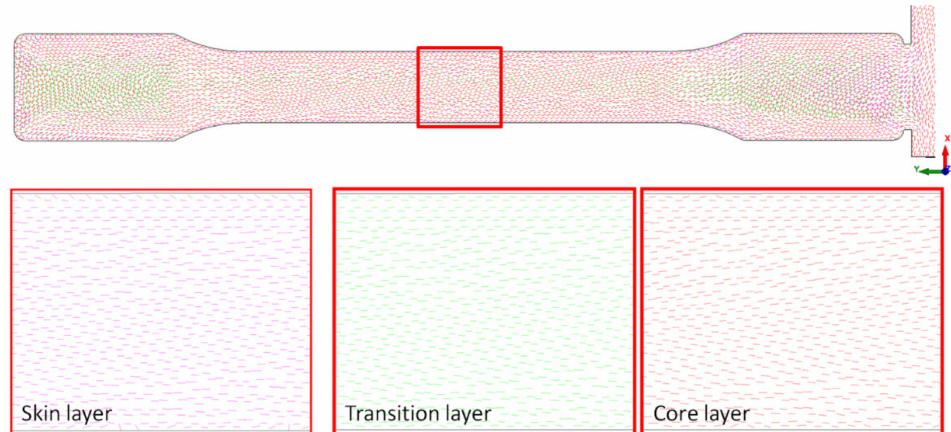
Figure 11. Simulation of the fiber orientation in the center of a measuring part (marked with a red square) for a skin, transition and core layer in a porous sample